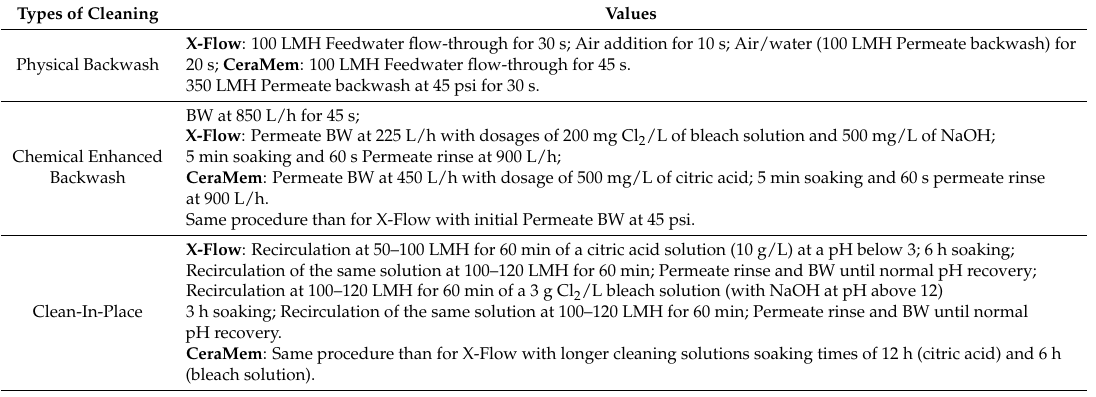
Table 3. Membranes cleaning